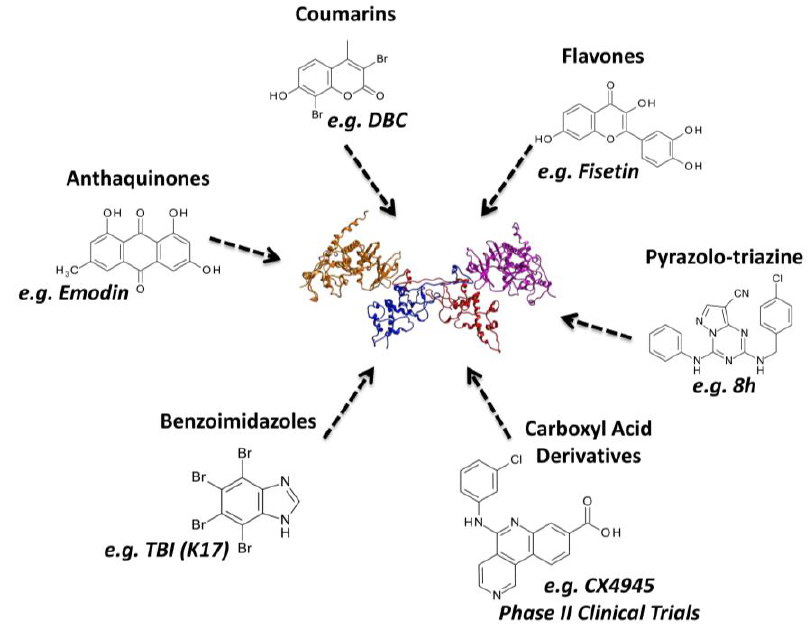
Figure 3. Schematic summary of the most representative families of CK2 inhibitors.